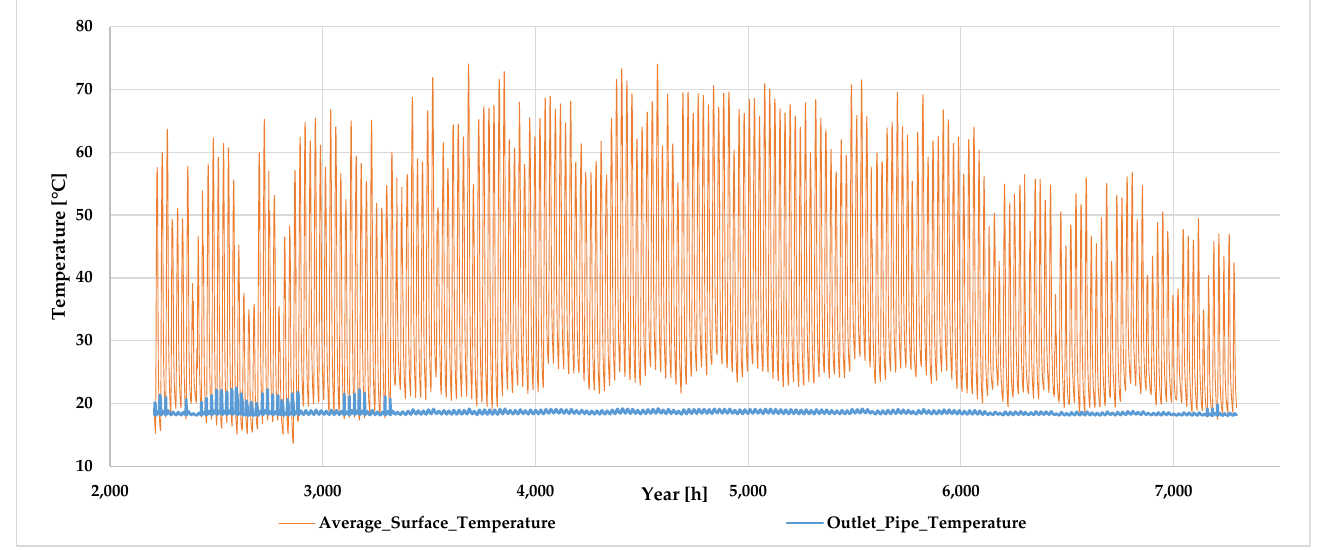
Figure 11. Temperature trend of the surface pavement and the pipeline for the RTC system with Re = 10,000.